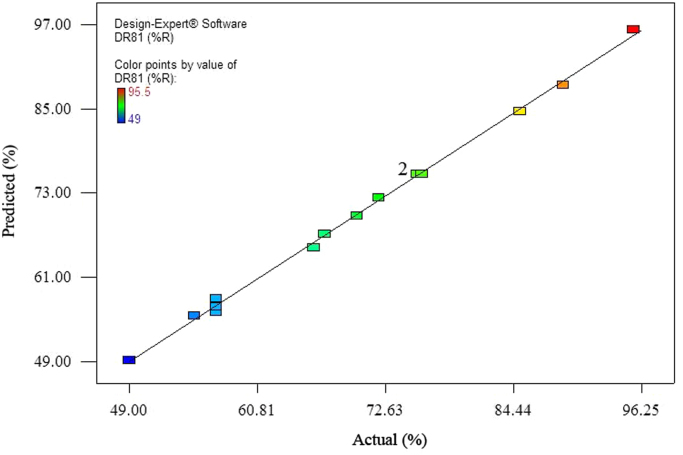
Comparison of experimental data with the RSM model predictions.